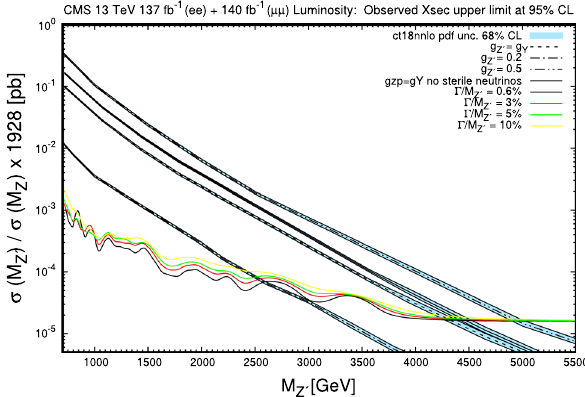
PDF uncertainties on the total cross sections obtained at 68% CL which are represented by blue bands in the two